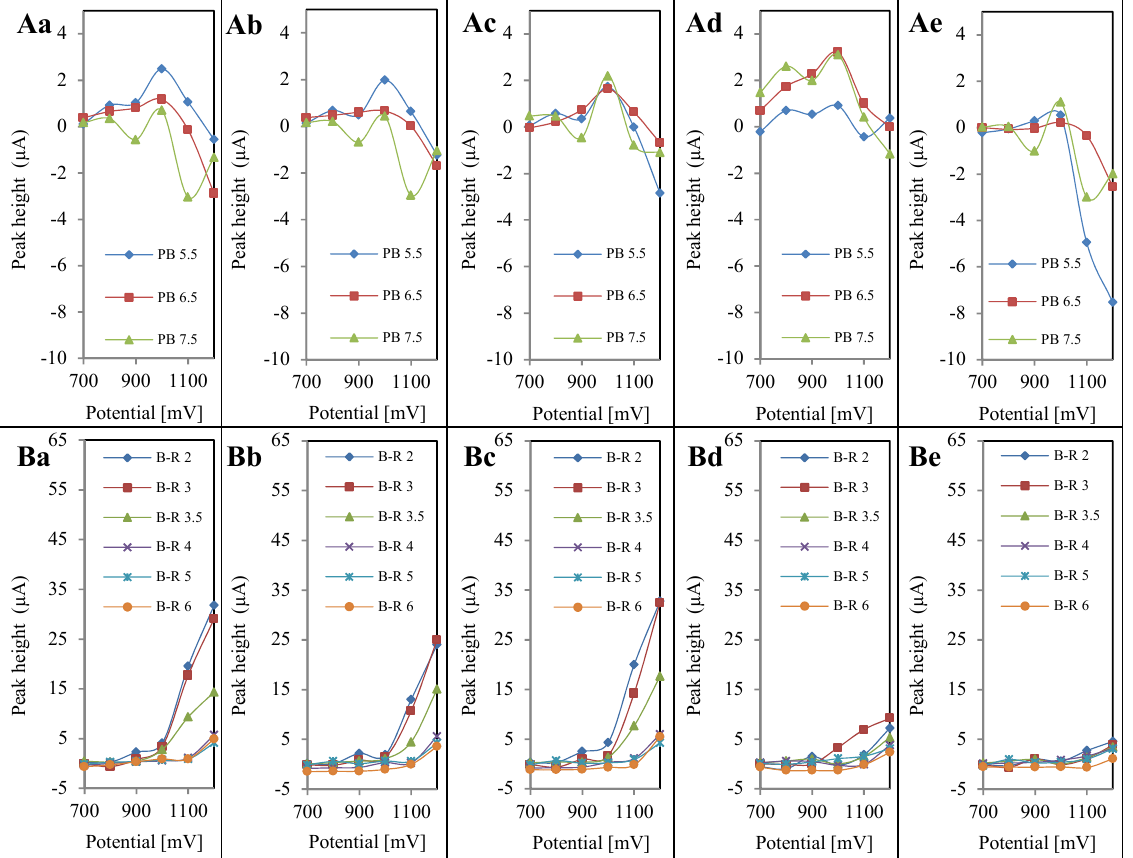
; ( Ae ) PtCl ; and ( B ) Britton-Robinson buffer 2 4 ; ( Be ) PtCl 2 4